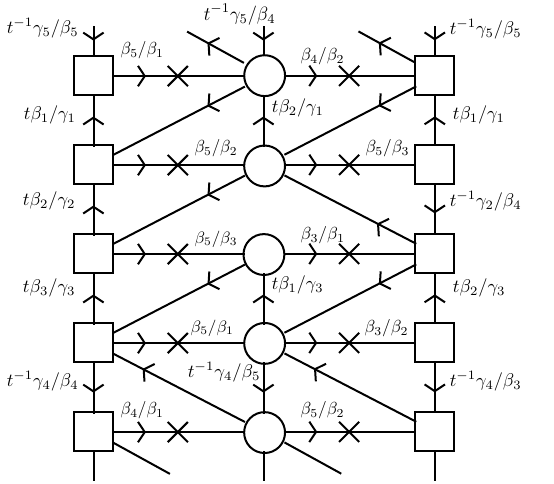
Figure 4 . Gluing two domain walls with D 1 = f + ; + ; + ; (cid:0) ; (cid:0)g (cid:12) and D 2 = f + ; (cid:0) ; + ; (cid:0) ; (cid:0)g (cid:12)